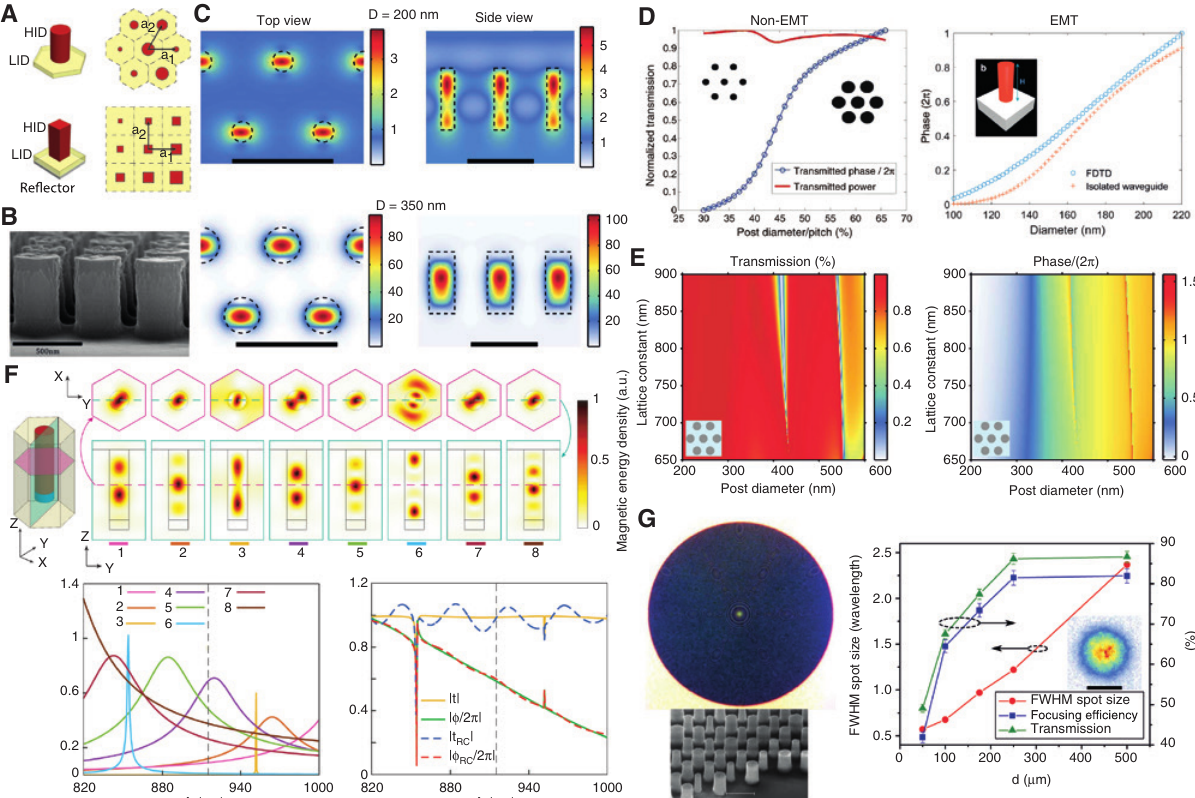
Figure 2: Operation principles of HCAs. (A) Schematic illustration of some possible HCA configurations with different nano-post shapes and lattice structures. HID: high-index dielectric, LID: low-index dielectric. (B) Scanning electron micrograph of a graded index lens, etched directly into a silicon wafer [117]. (C) Simulated magnetic energy density in a periodic array of α -Si nano-posts plotted in cross-sections perpendicular to (left) and passing through (right) the nano-posts’ axes. For larger nano-posts, the field is highly confined inside the nano-posts. The scale bars are 1 μ m [67]. (D) Simulated transmission phase for α -Si nano-posts operating beyond the EMT regime (left, [66]) and TiO the EMT regime (right, [118]). (E) Simulated transmission amplitude and phase of a periodic array of circular α -Si nano-posts versus post diameter and lattice constant [67]. (F) Top: Magnetic energy distribution of optical resonances inside an α -Si nano-post that contribute to the transmission amplitude and phase of the structure around 900 nm [119]. Bottom: reconstruction of the nano-post transmission and phase using the frequency responses of the resonance modes. The left figure shows relative contributions of the different modes. (G) Near-IR lenses fabricated with α -Si HCAs, and their performance as high-NA lenses with high efficiency [67]. The lenses are designed to focus light emitted by a single-mode optical fiber to a diffraction-limited spot. The lenses have NAs from ~ 0.5 to ~ 0.97 and measured focus- ing efficiencies of 82% to 42%. Scale bar: 1 μ